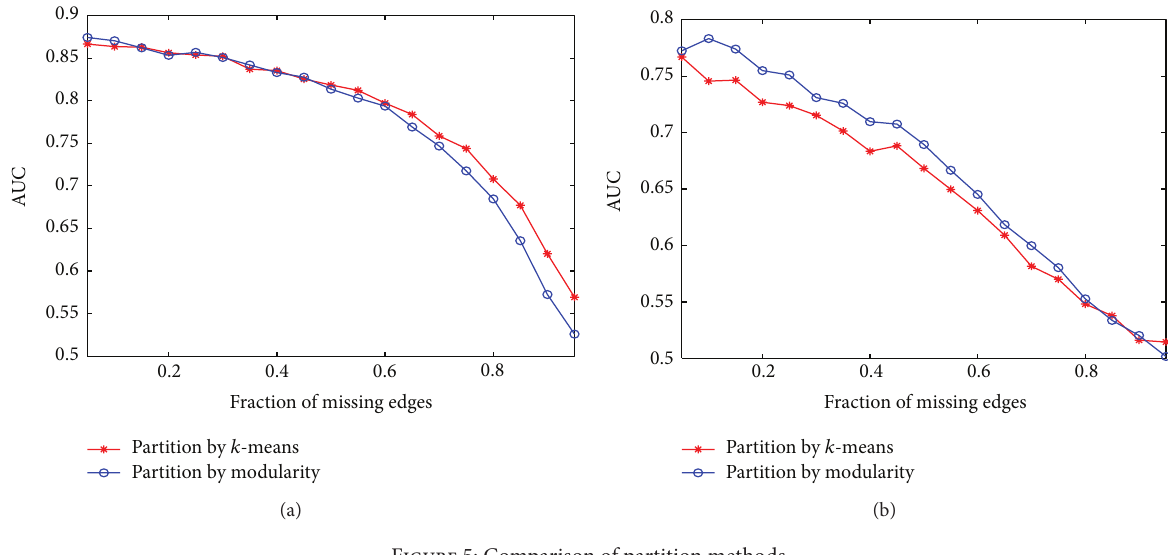
Figure 5: Comparison of partition